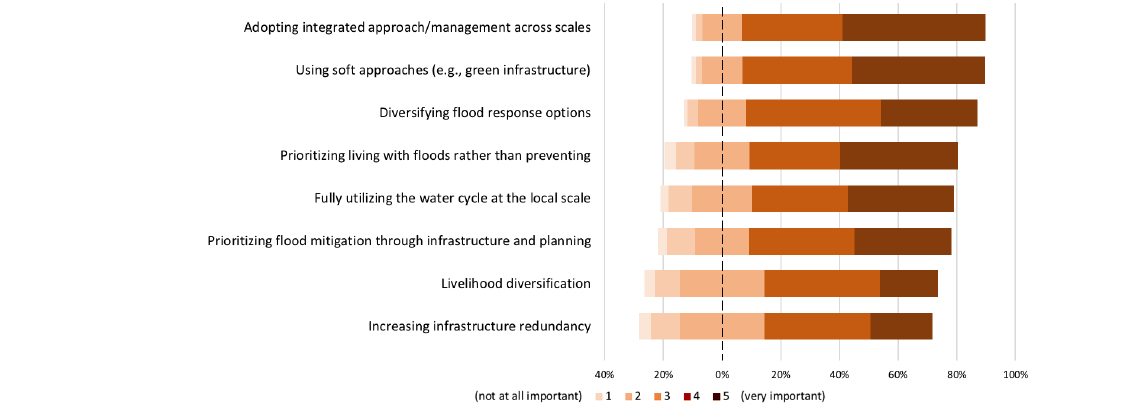
Fig. 4 . Strategies that build resilience to flooding. Survey respondents were asked to rate, on a scale of 1 to 5, each of the strategies in terms of how important they are for achieving resilience to flooding. While the strategies were randomly ordered on the survey, they are shown here from the highest rated at the top to the lowest rated at the